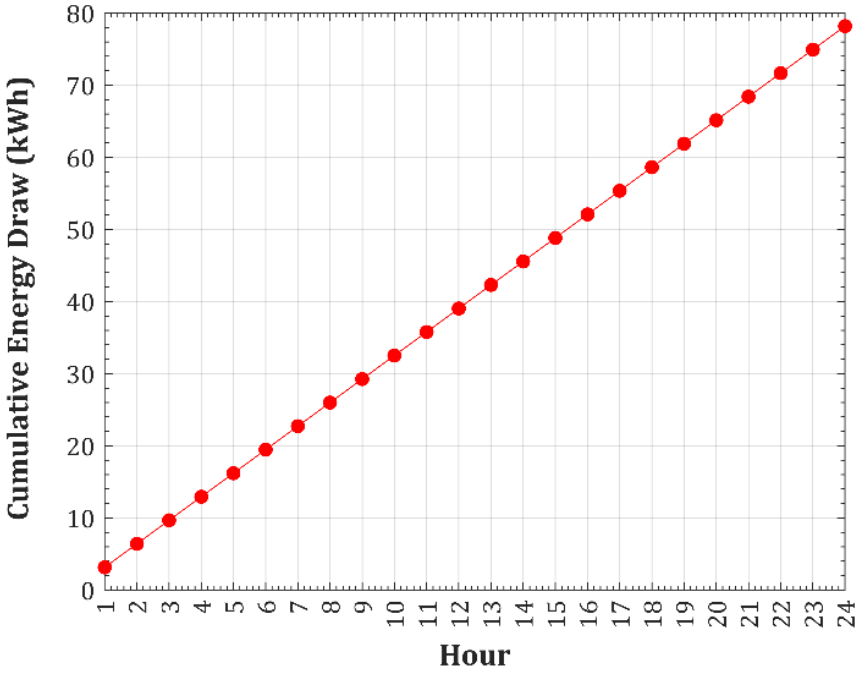
Figure 5. Representative total cumulative Antminer S17e experimental energy draw measurements over a 24-hour period in kWh across the two power cables.